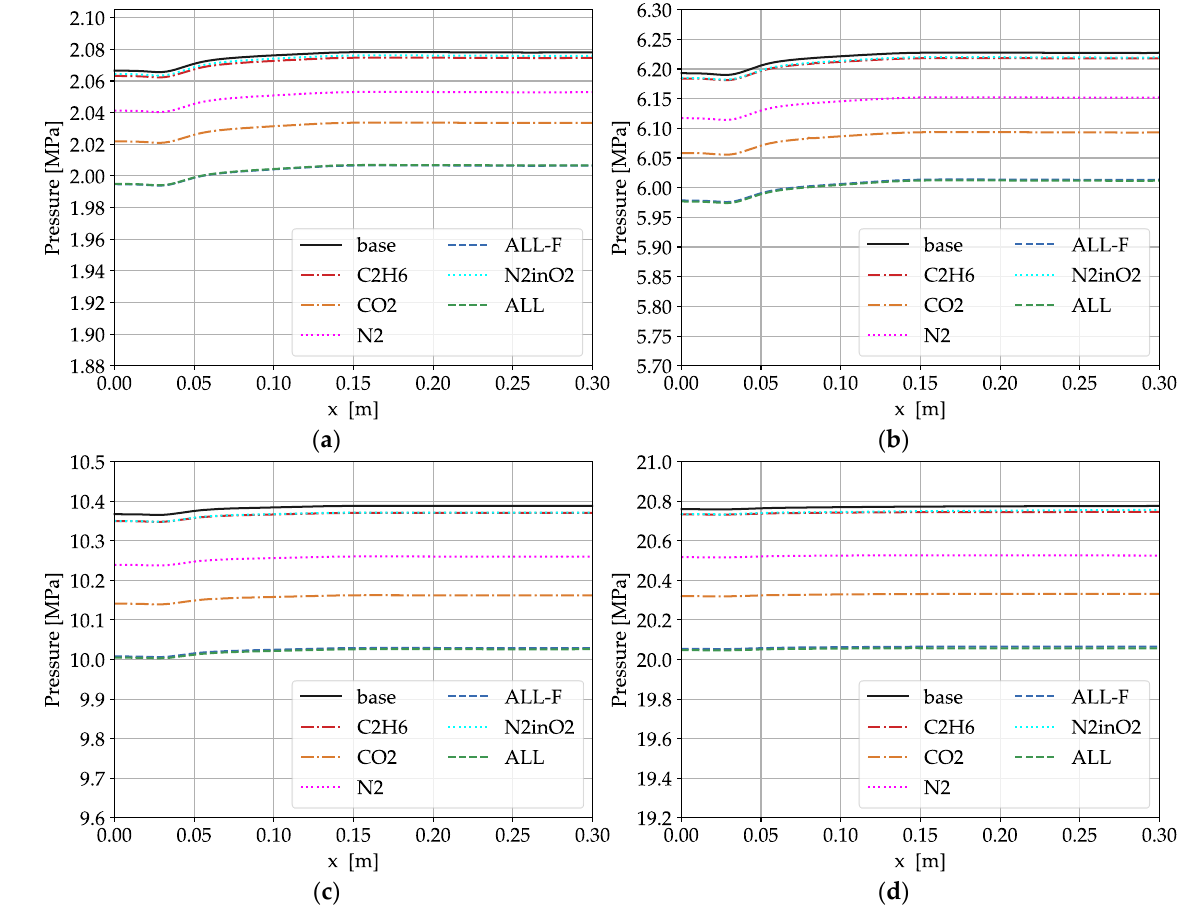
Figure 10. Combustion chamber wall pressure for different pollutants of the fuel and/or oxidizer at the combustion chamber configuration: ( a ) p02 (target pressure 2 MPa), ( b ) p06 (target pressure 6 MPa), ( c ) p10 (target pressure 10 MPa), and ( d ) p20 (target pressure 20 MPa).